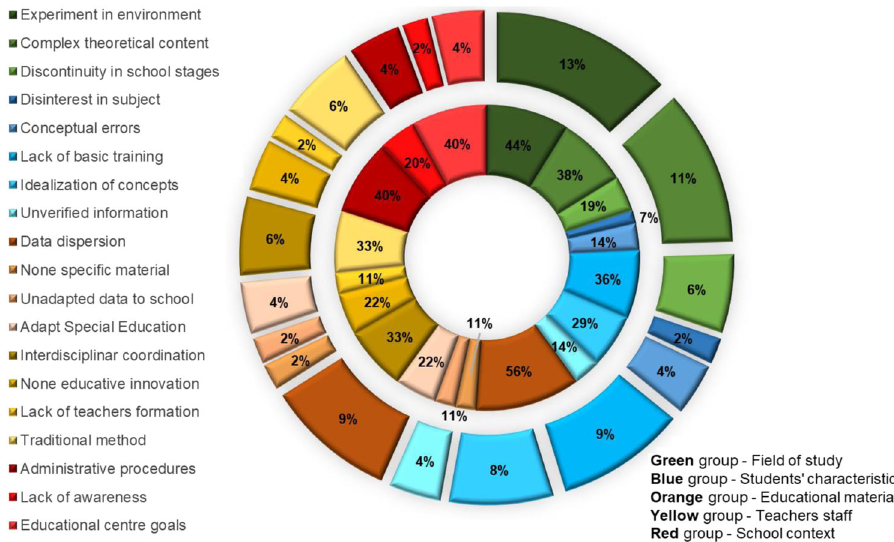
Fig. 4 Teacher ’ s perception of climate and landscape learning dif fi culties. The inner ring represents the relative frequency of each dif fi culty within its group. The outer ring represents the absolute frequency of each dif fi culty within the whole array of dif fi